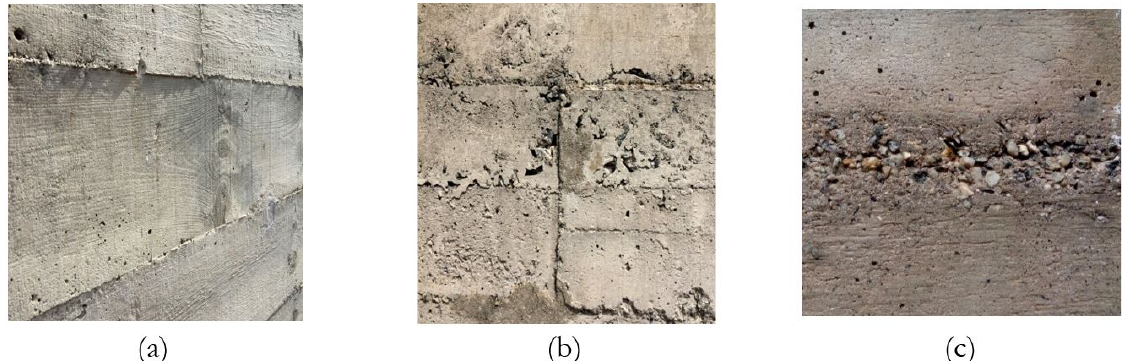
Figure 3. Characteristics of the exposed concrete of façades in Artigas building: (a) wood grain pattern on the surface (width 30cm); (b) rough surface texture and air voids; (c) segregation in construction joint. (Images: Collection of ConservaFAU,